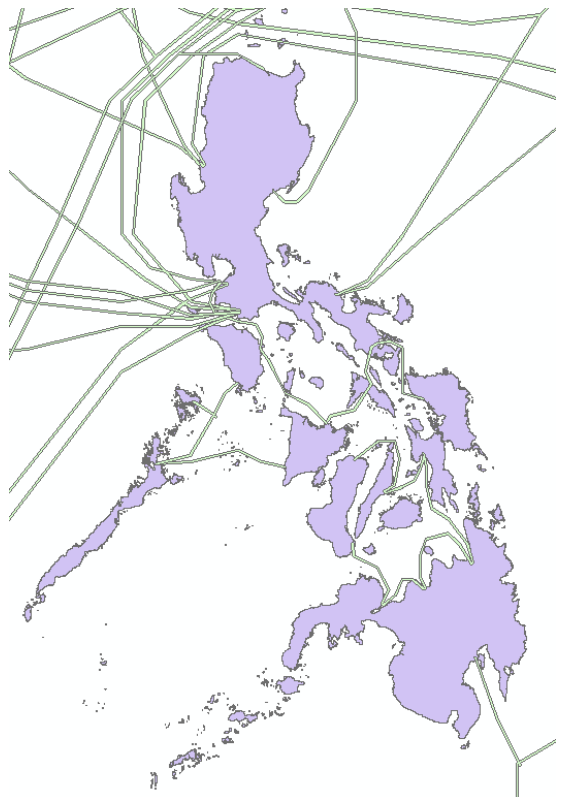
Figure 2. Detailed exclusion analysis.